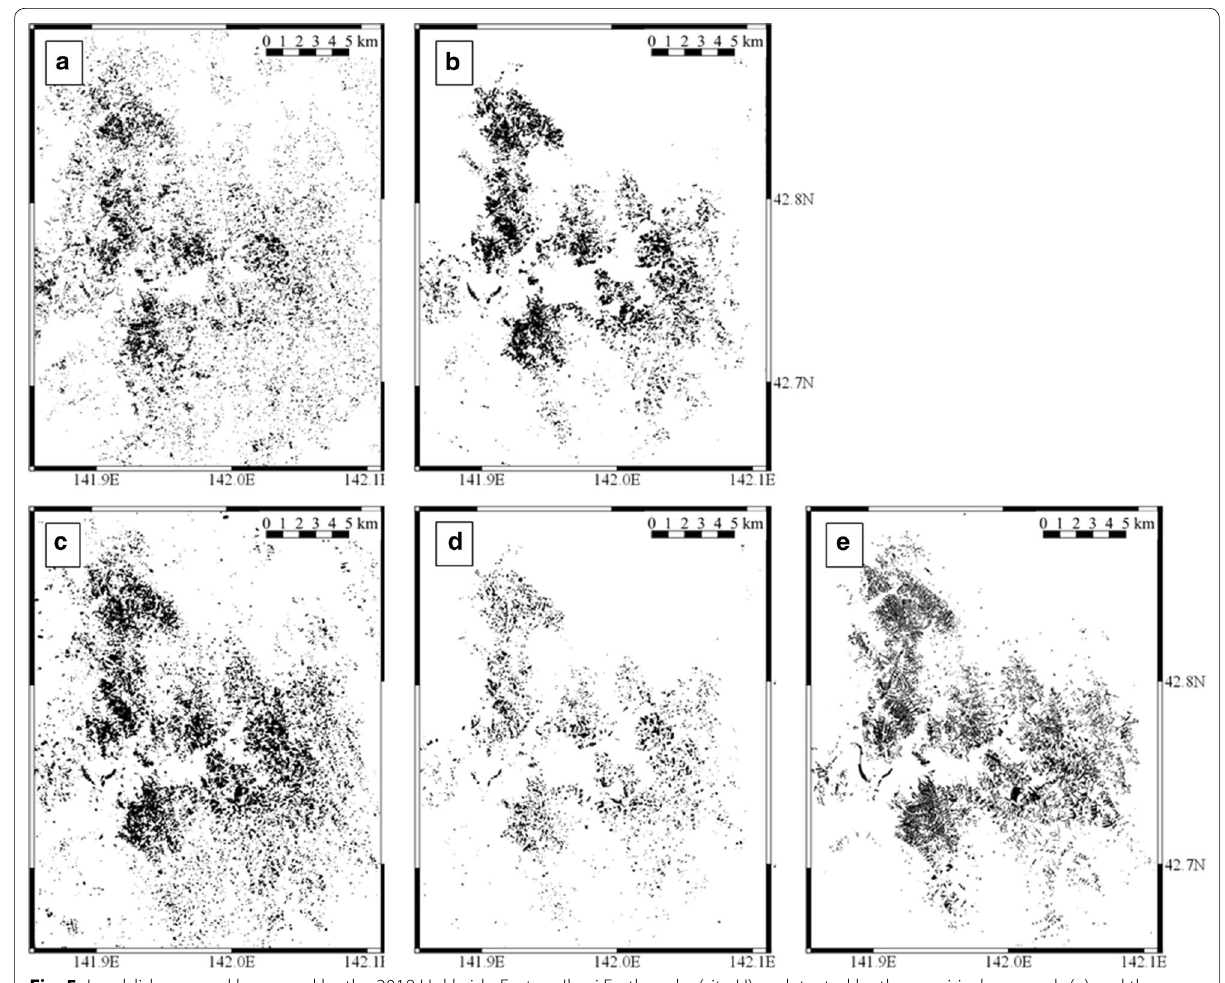
Fig. 5 Landslides caused by caused by the 2018 Hokkaido Eastern Iburi Earthquake (site H) as detected by the empirical approach ( a ) and the supervised classification ( b–d , same as Fig. 4), compared with the reference data by GSI (2018) ( e